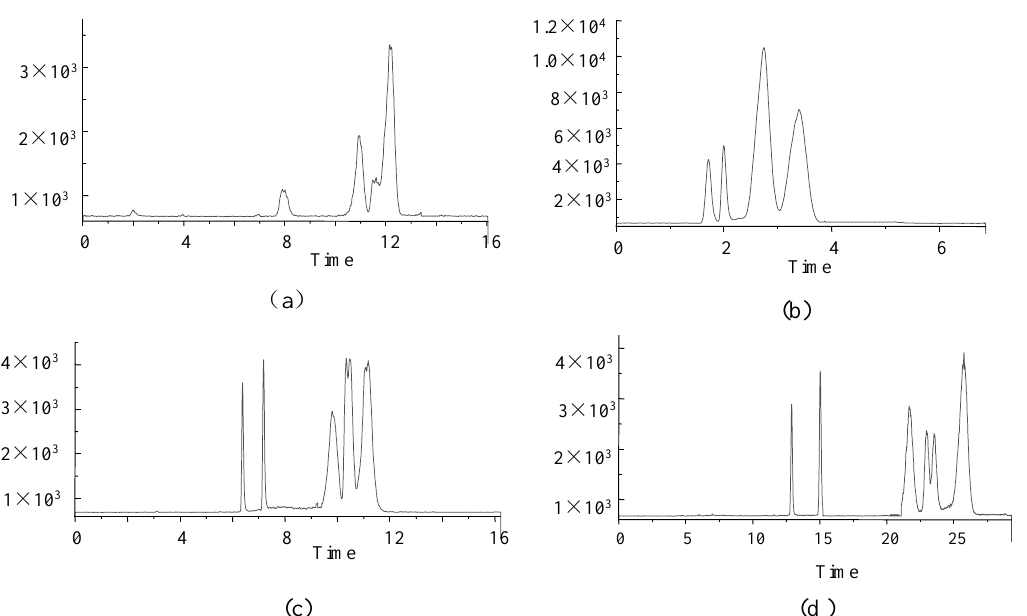
Figure 2. TIC of 6 analytes under four columns ( a ) Phenomenex Luna Omega 3 µ m PS C18 100 Å; ( b ) Agilent Eclipse Plus C18; ( c ) Agilent Poroshell 120 EC-C18; ( d ) Agilent ZORBOX SB-C18. (FK- 506 and PIM at 100 ng · mL − 1 , RAPA and EVER at 500 ng · mL − 1 , MMF at 10 ng · mL − 1 and MPA at 1000 ng · mL − 1 ).